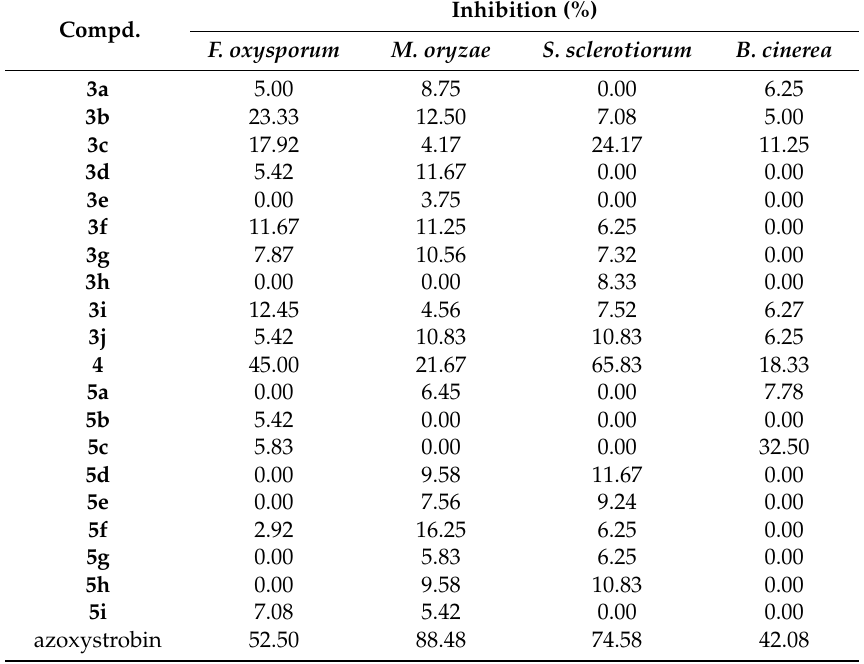
Table 4. Antifungal activities of compounds 3a – j , 4 , 5a – i and azoxystrobin against F. oxysporum , M. oryzae , S. sclerotiorum , B. cinerea at 50 mg/L.